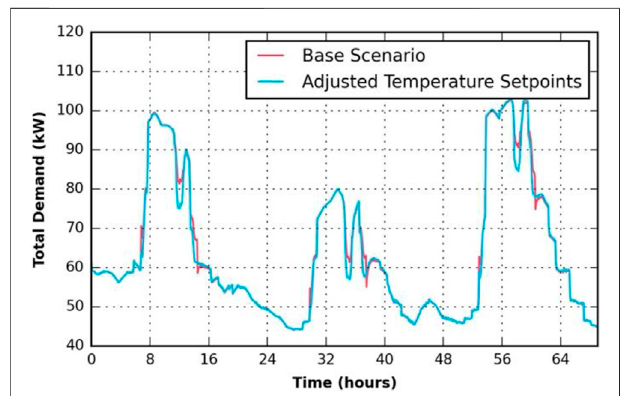
FIGURE 13 | Improving building electricity demand by adjusting temperature setpoints following of fi ce